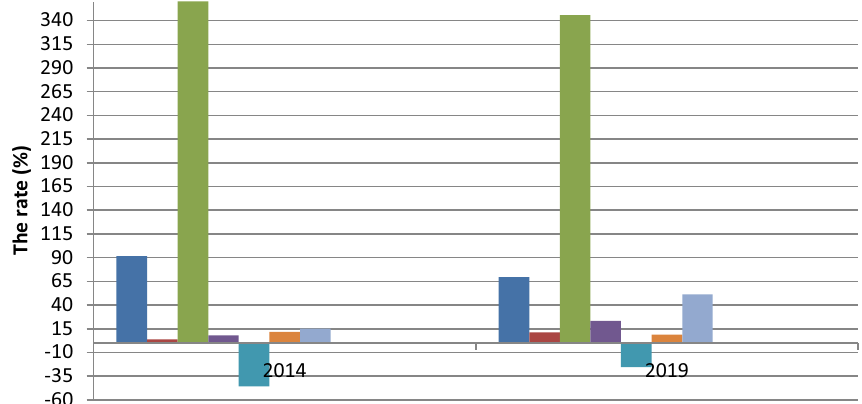
Fig. 15 The rate of change in NO 3− between 2014 and